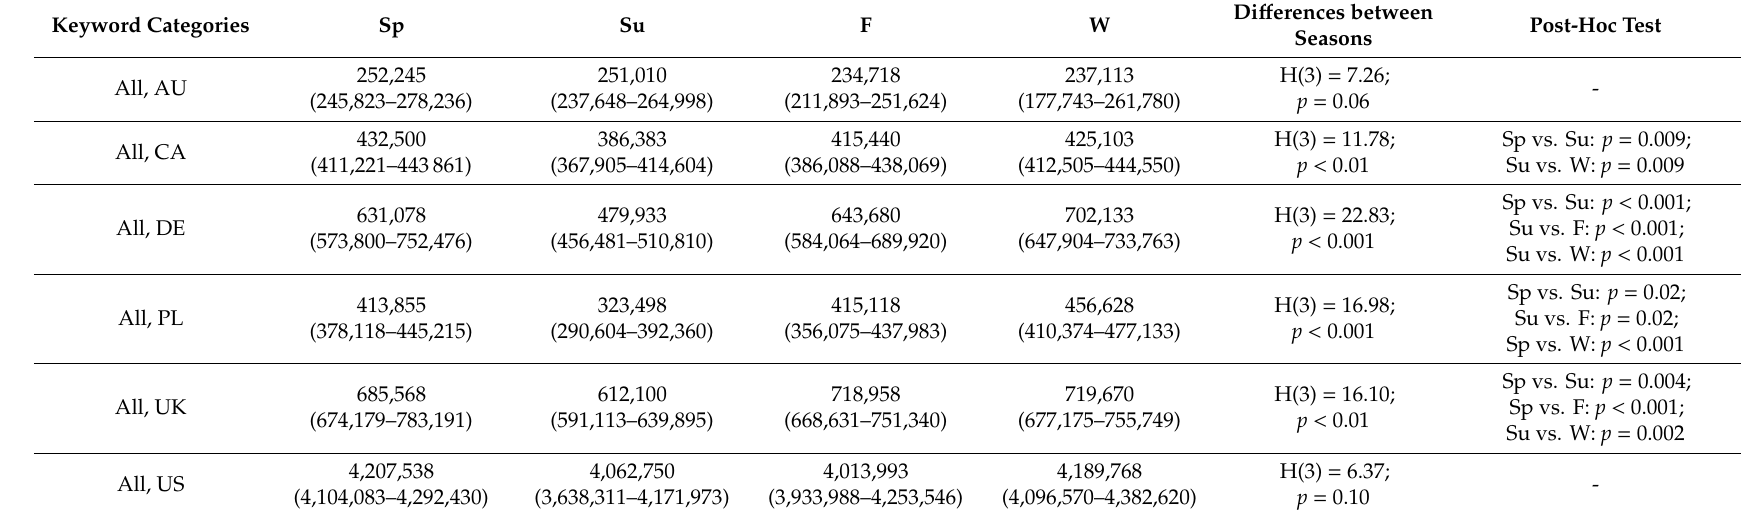
Table 2. Comparison regarding heartburn-related searches per month for each